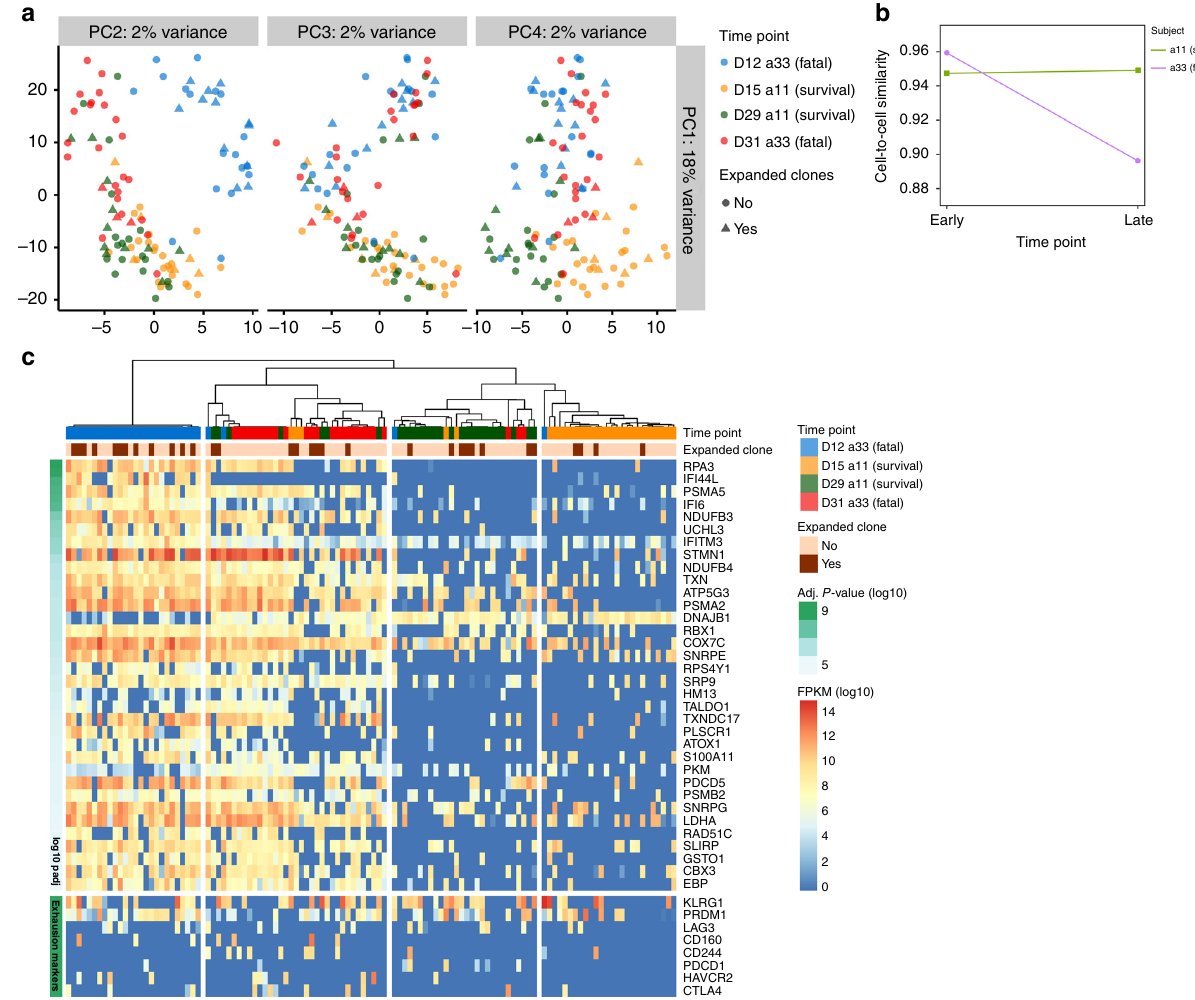
Fig. 6 Global differences at the transcriptome levels within CD38 + HLA-DR + CD8 + cells. Single-cell RNAseq (scRNAseq) was performed on CD38 +